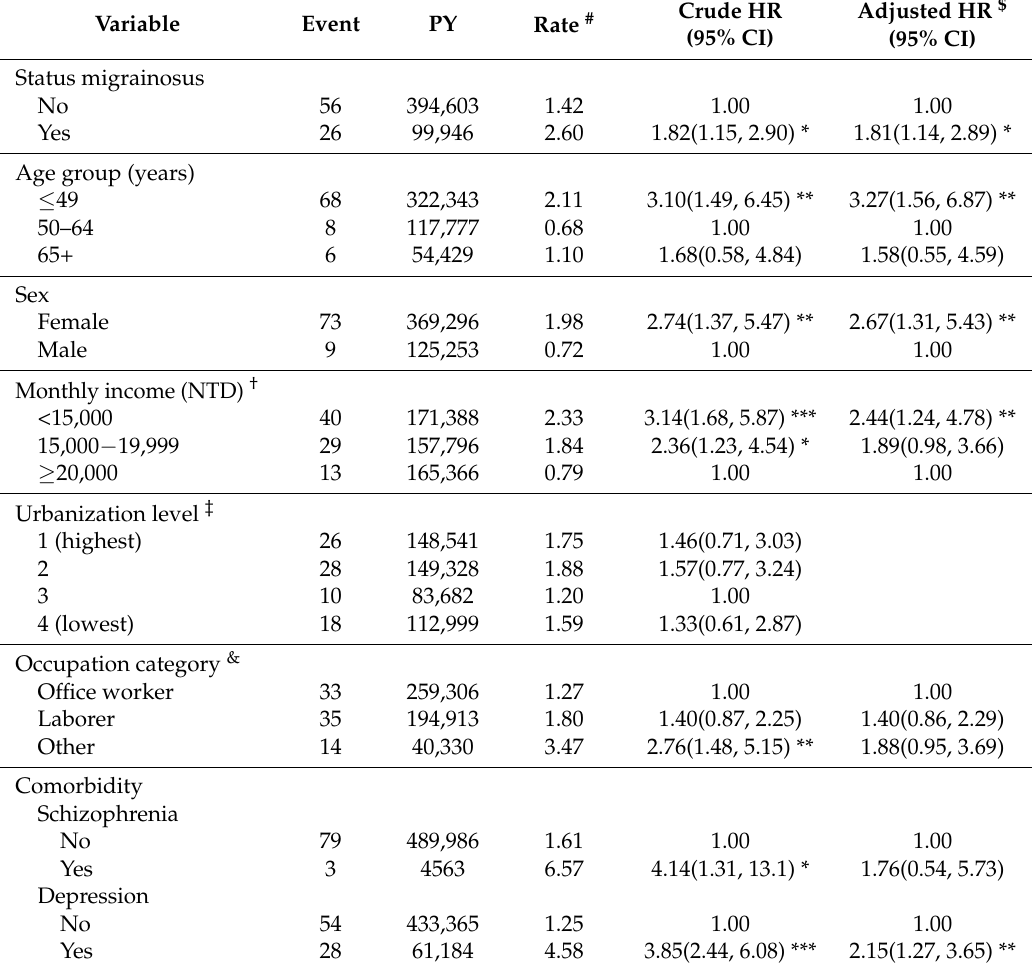
Table 2. Incidences and risk factors for suicide attempt with or without status